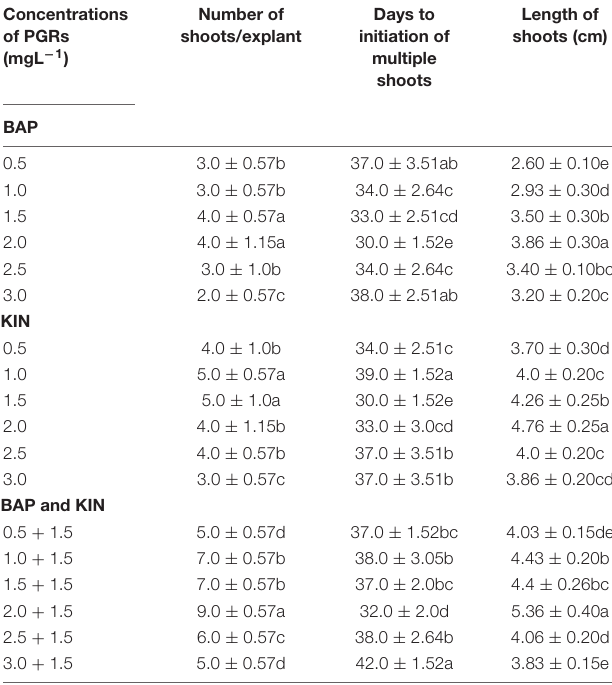
TABLE 1 | In vitro responses of shoot tip explants of Withania somnifera to different concentrations of PGRs. Concentrations Number of of PGRs